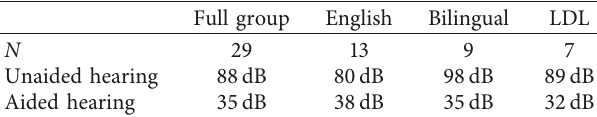
Table 1: Student demographics by full group and language